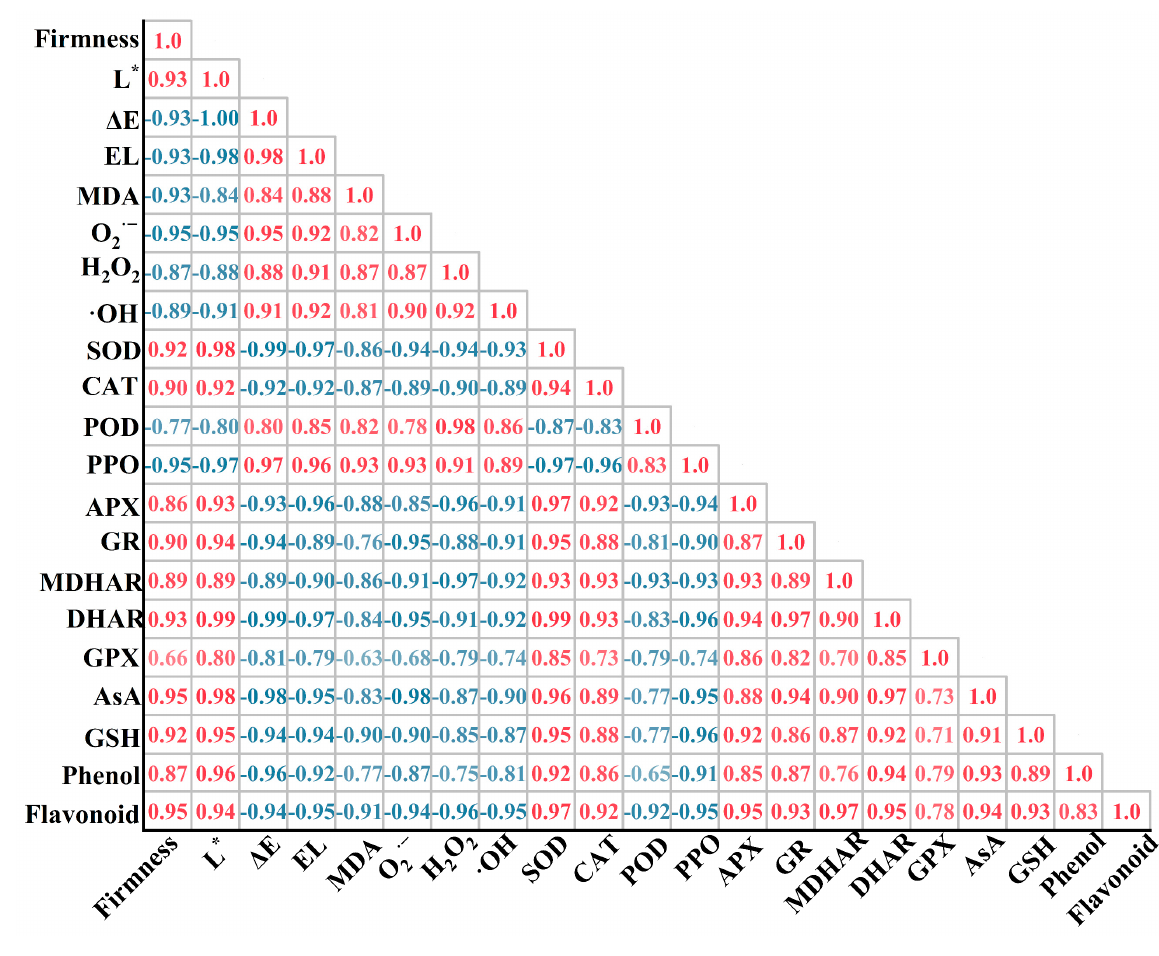
Figure 6. Pearson correlation coefficient matrix between each index of Agaricus bisporus stored at 25 °C for the sixth day. Red and blue colors represent positive and negative correlations between factors.